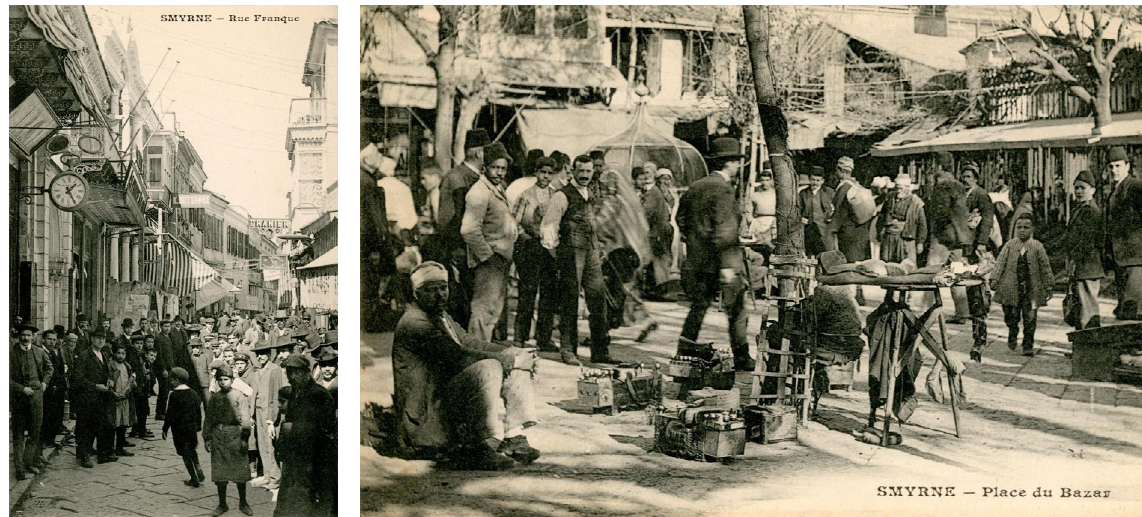
FIG. 6 Lively photos of two different districts from Smyrna, at the end of the nineteenth century, ©SALT Research 33 On the left: View from the Frank Street On the right: View from the Bazar